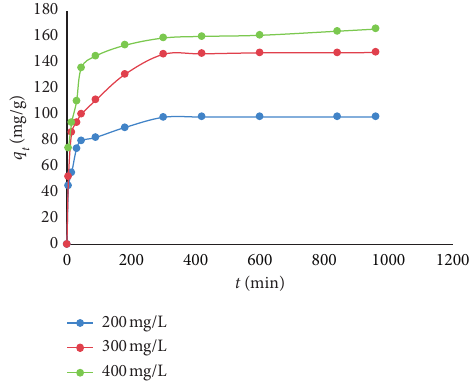
Figure 2: Impact of contact time on MnO ZCOBLP.